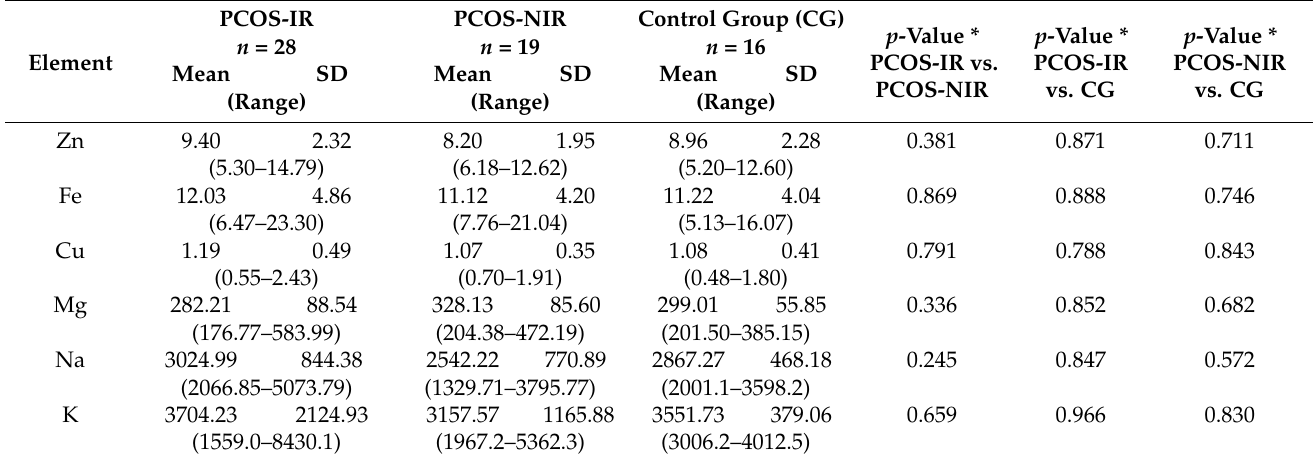
Table 3. Trace element content in diets ( µ